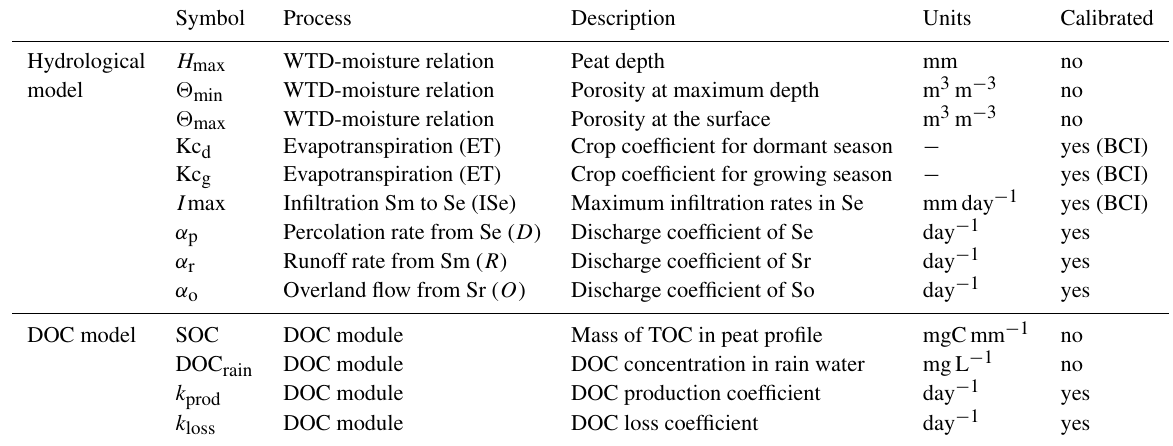
Table 1. List of the parameters used in the hydrological and the DOC models. The hydrological flux associated to each parameter is in parenthesis. Calibrated parameters and boundary condition independent (BCI) parameters are